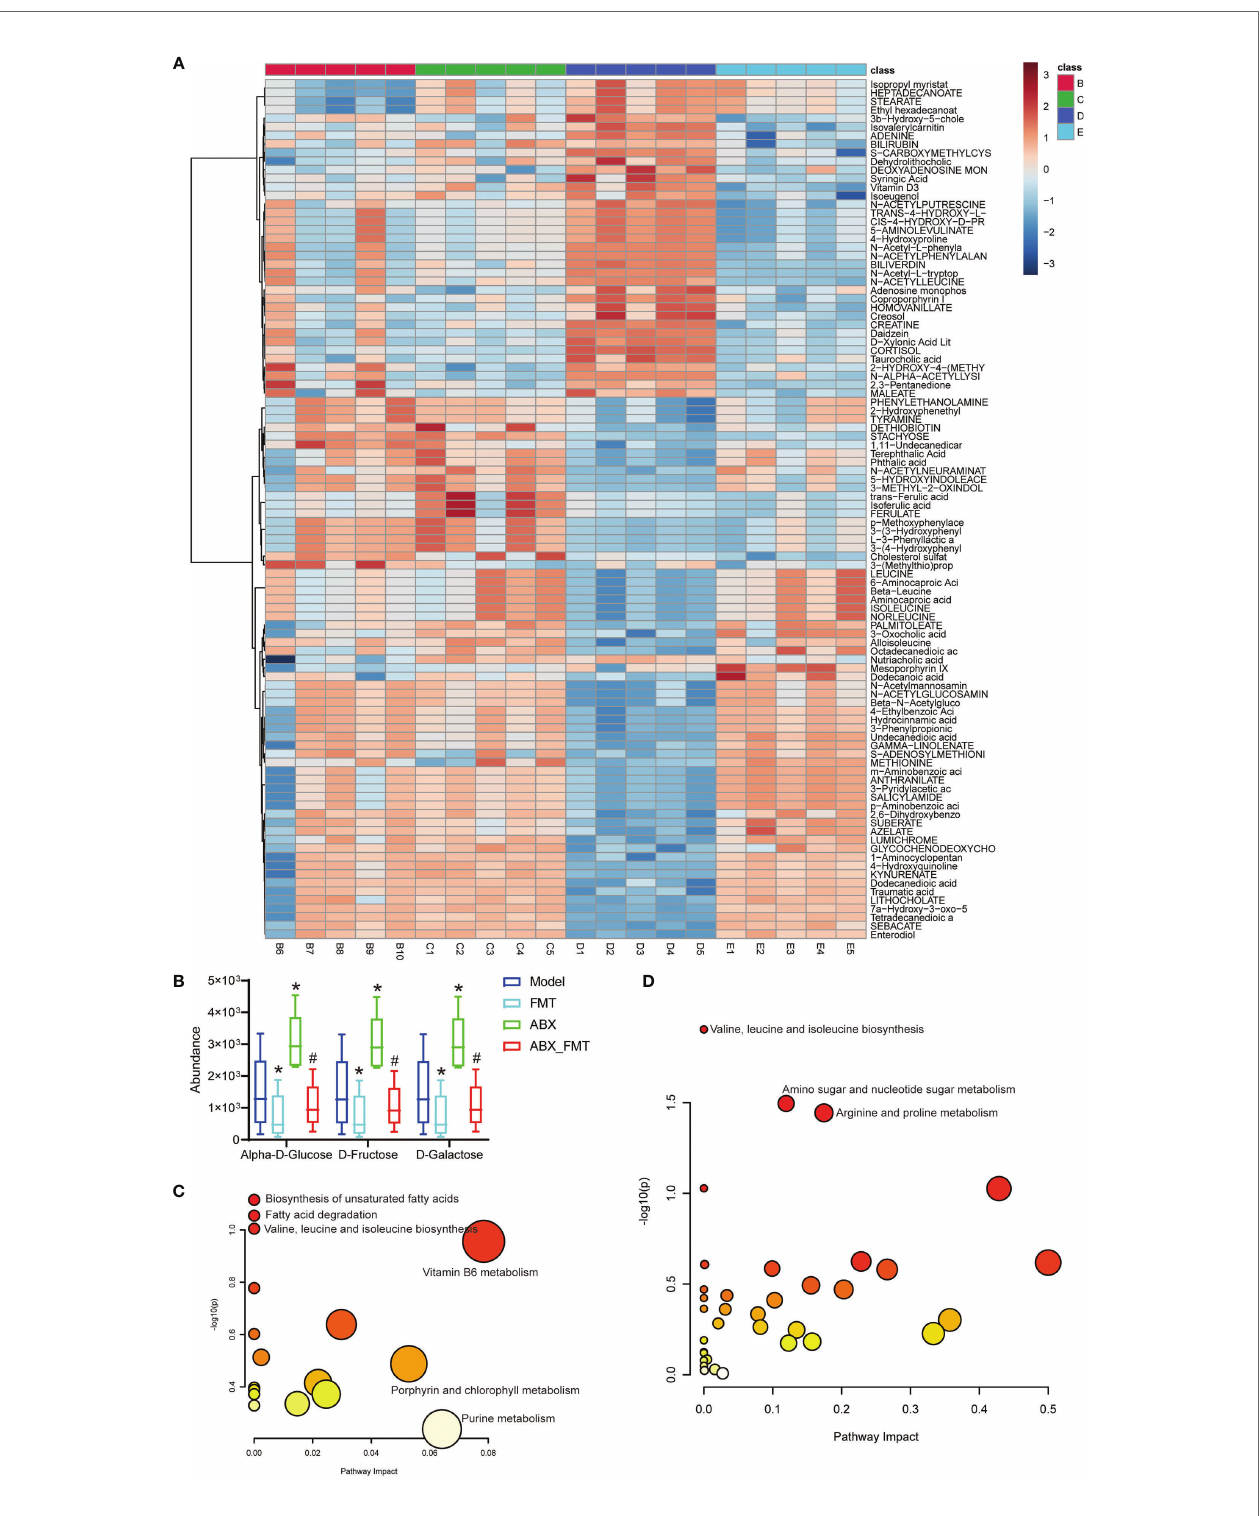
FIGURE 6 | FMT improved gut metabolism and function in mice with acute pneumonia (n=10 mice/group). (A) Heatmap showed changes of metabolites in mice with acute pneumonia. (B) The abundance of D-galactose, alpha-D-glucose and D-Fructose metabolites. (C) KEGG annotation was used to analyze the metabolite functions of model group and FMT group. (D) KEGG annotation was used to analyze the metabolite functions of ABX group and ABX_FMT group. *P < 0.05 vs control group; #P < 0.05 vs ABX group. N=5 sample/group for Non-targeted Metabolomics